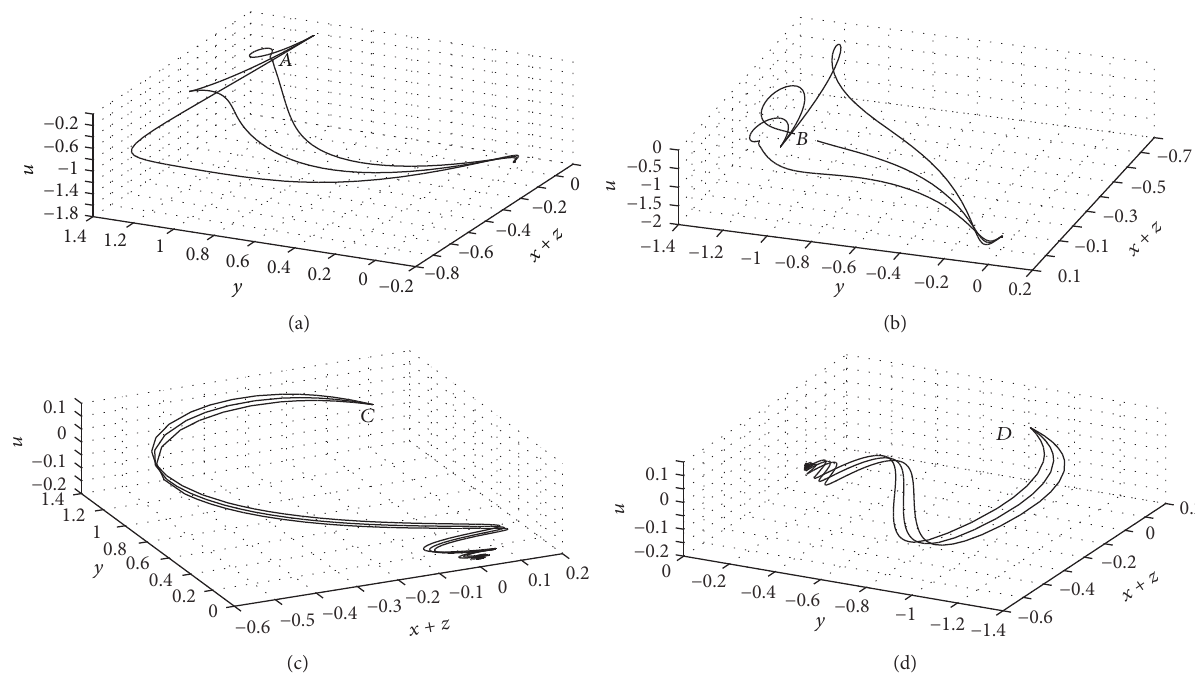
Figure 5: Three-dimensional plots of the phase-space trajectories for the critical points 𝐴 , 𝐵 , 𝐶 , and 𝐷 being the stable attractors.